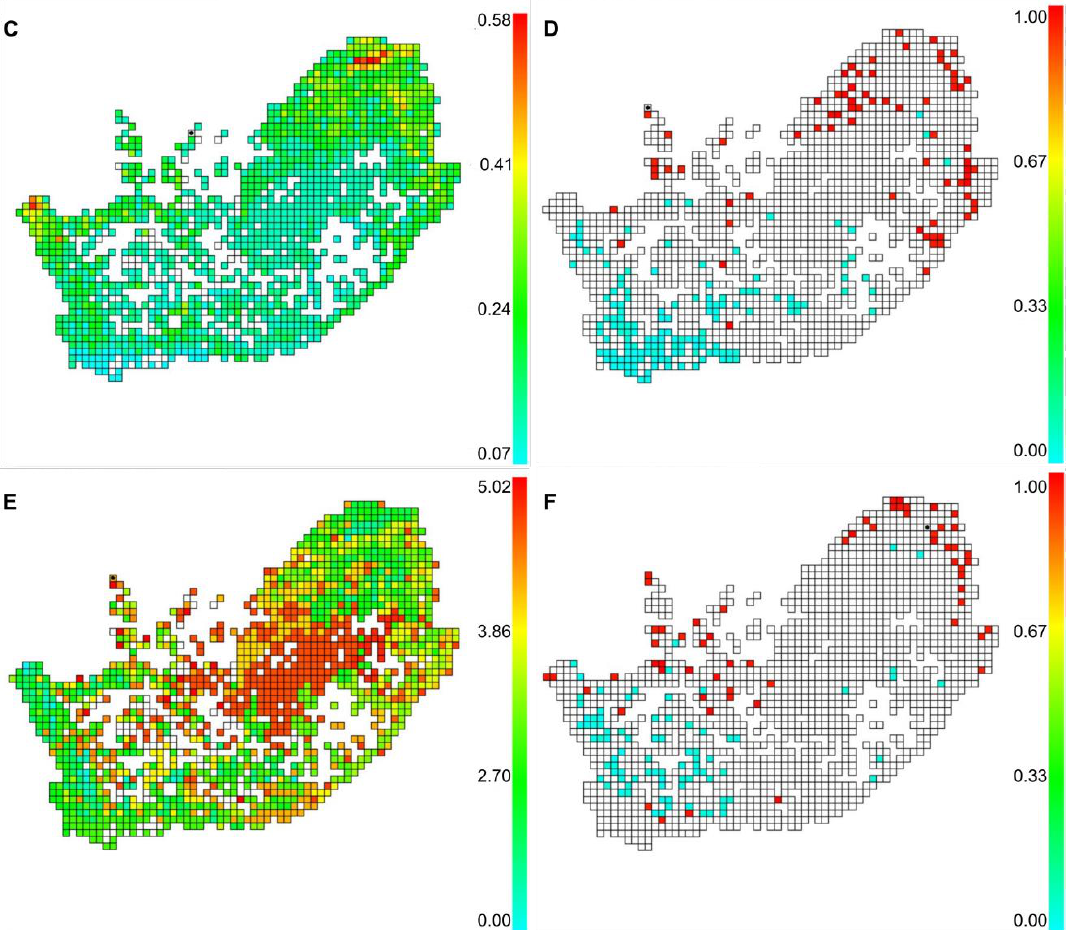
Figure 4. Maps of various diversity and endemism indices: ( A ) Taxonomic Richness (TR), ( B ) Shannon’s Diversity index (SD), ( C ) Phylogenetic Diversity (PD), and ( E ) Relative Phylogenetic Diversity (RPD). Maps showing significance levels resulting from a randomization test for ( D ) PD and ( F ) RPD. The red values indicate grid cells that contain significantly less PD/RPD than expected; the blue values indicate grid cells that contain significantly more PD/RPD than expected.